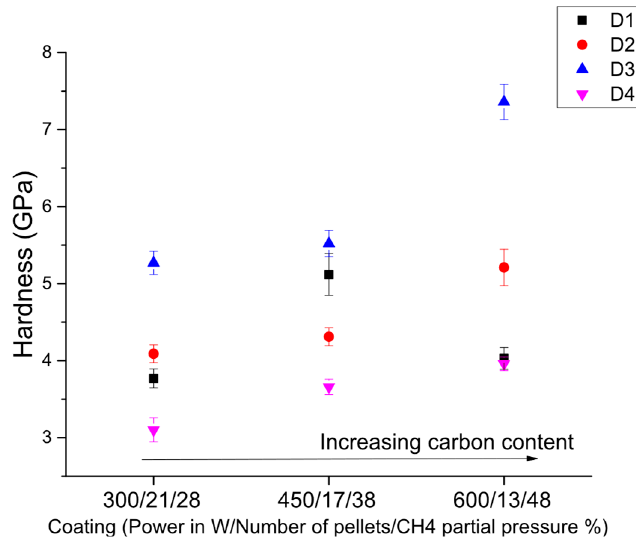
Figure 8. Hardness of the coatings.